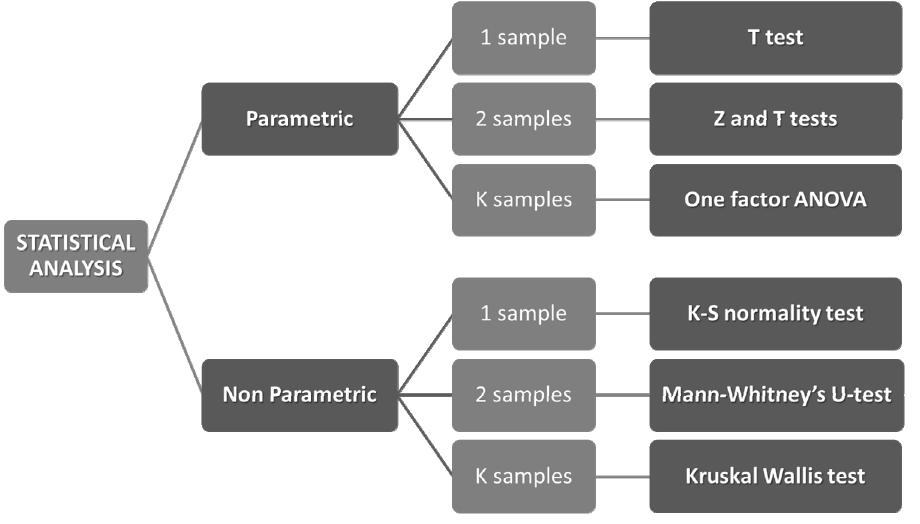
Figure 2. Scheme of the statistical methodology